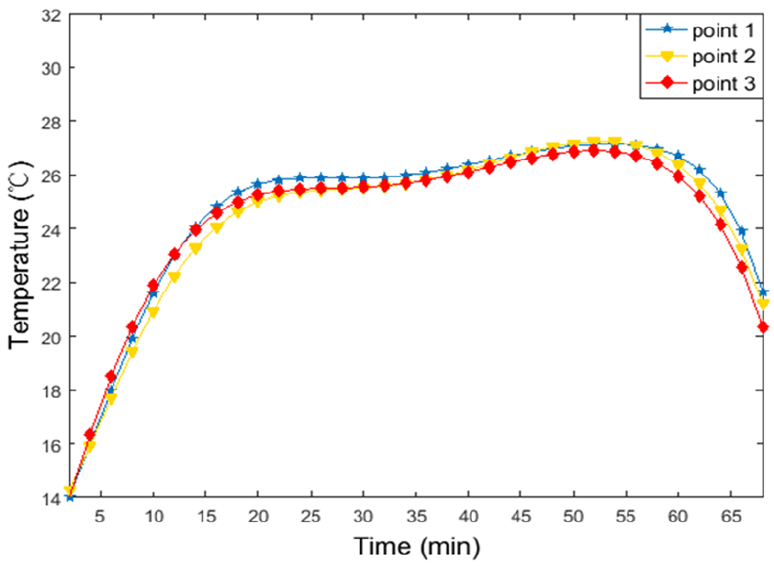
Figure 12. Temperature of each point in Experiment 1.